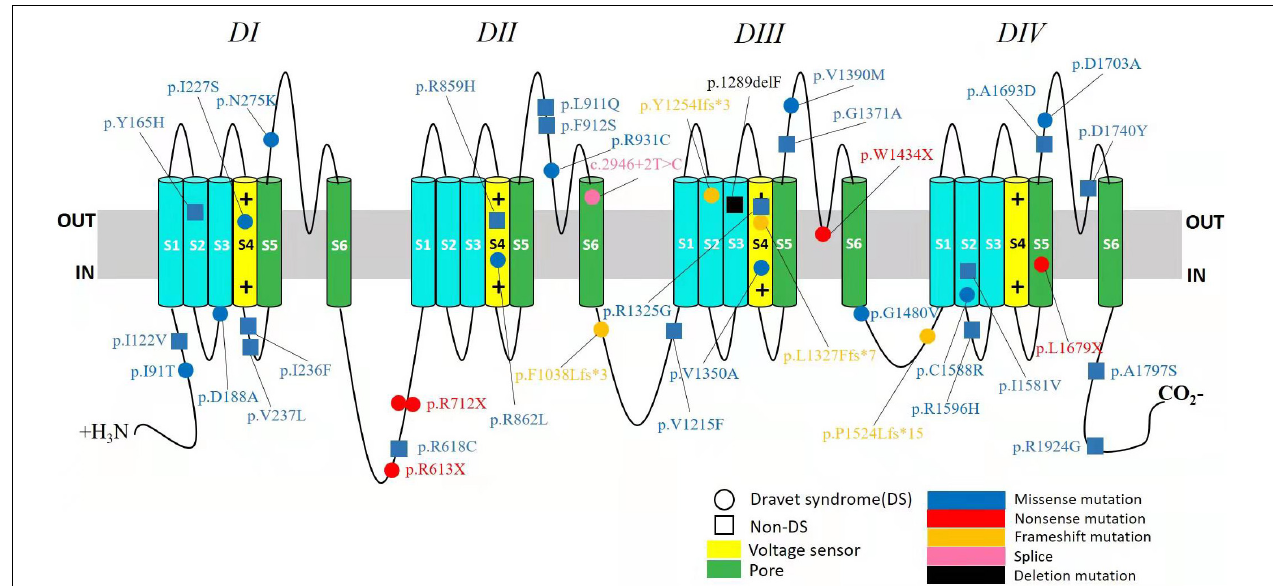
FIGURE 1 | Structure of the human Nav1.1 channel and the location of SCN1A variants identified in this study. Nav1.1 channels α subunit consist of four homologous domains (DI–DIV), each with six transmembrane segments (S1–S6). The fourth segment (S4) of each domain functions as a voltage sensor. The S5 and S6 segments of each domain make up the pore of the channel, and the connecting loop between S5 and S6 is the pore loop. The identified variants in DS group were depicted with circle and in non-DS group with square. Missense variants are shown in blue. Nonsense variants are shown in red. Frameshift variants are shown in orange. Splice site variant is shown in pink and deletion variant in black.